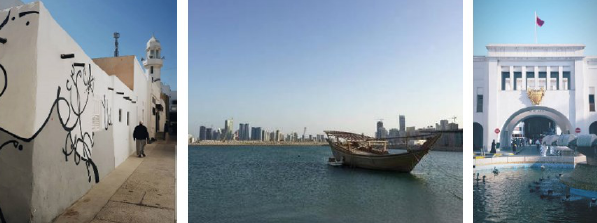
Figure 4. Inspiration of the Bahraini identity from heritage